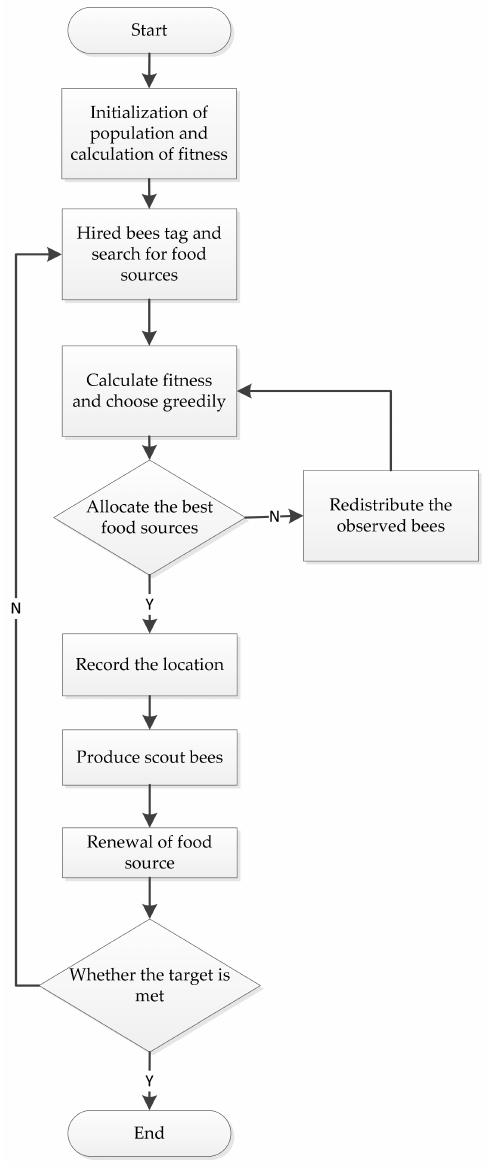
Figure 4. The flow chart of ABC